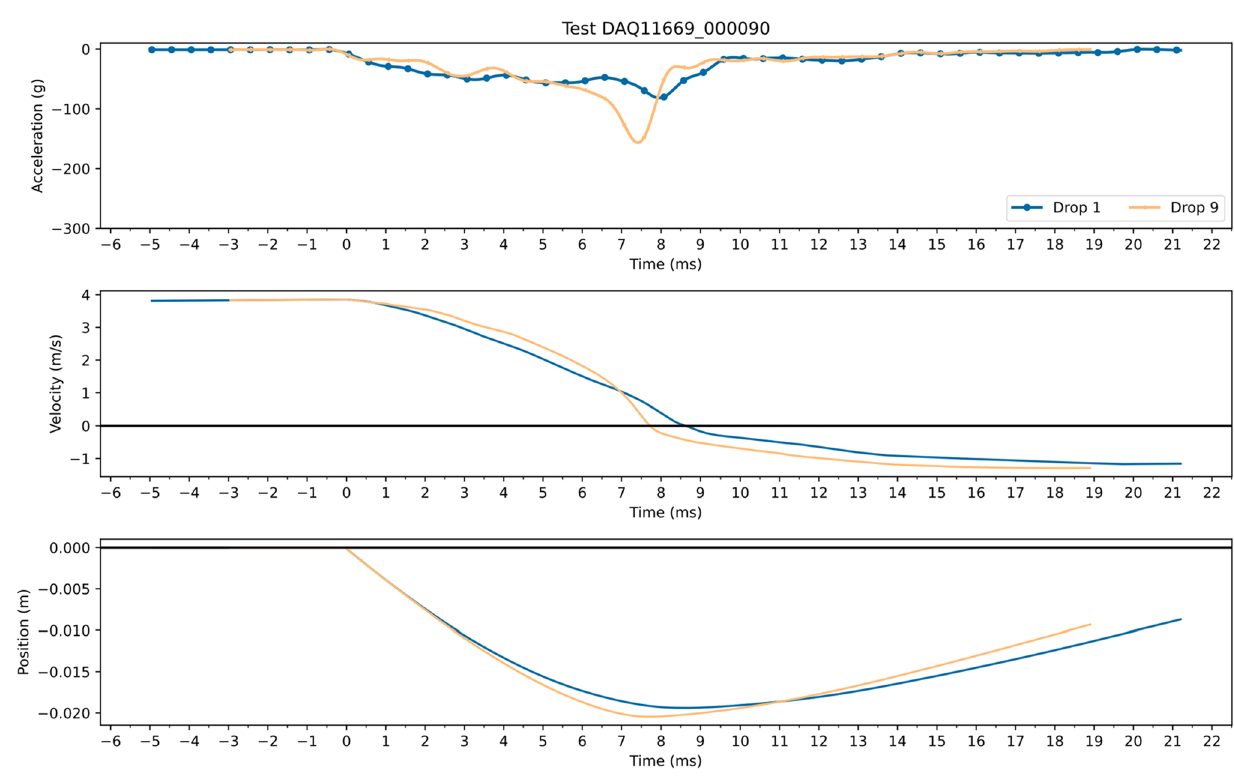
Fig. 11 Peak accelerations for three different drop sequences with P3 (865 g / 200 × 100 × 190 mm / 7–7-7 wrapping